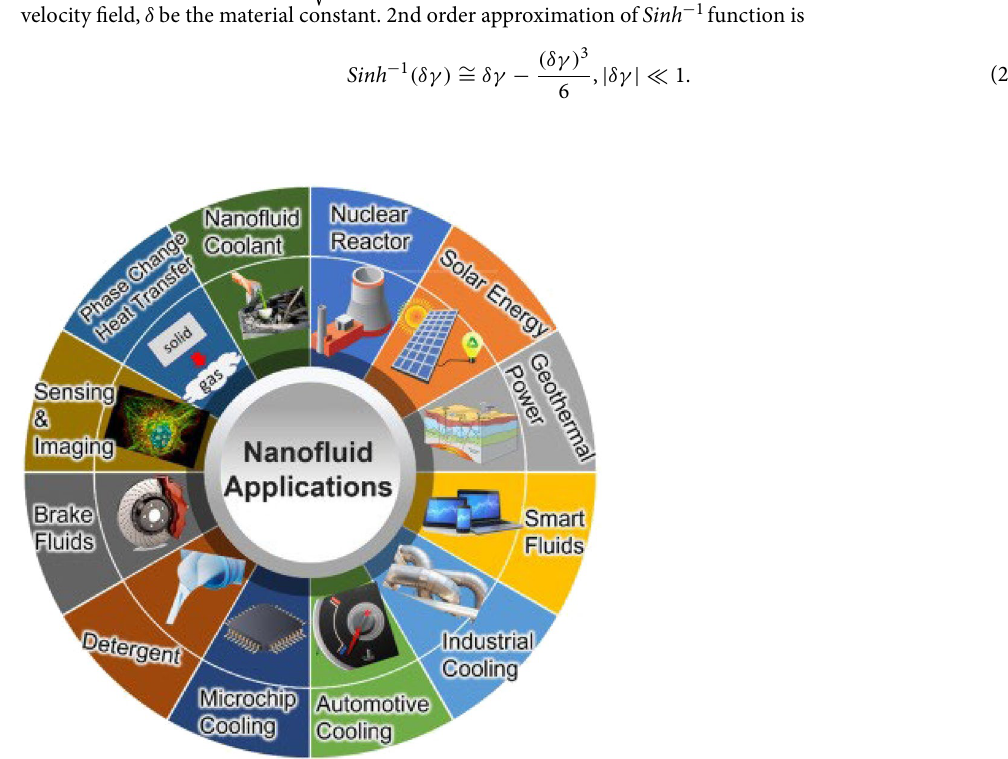
Figure 1. Illustrated physical applications of